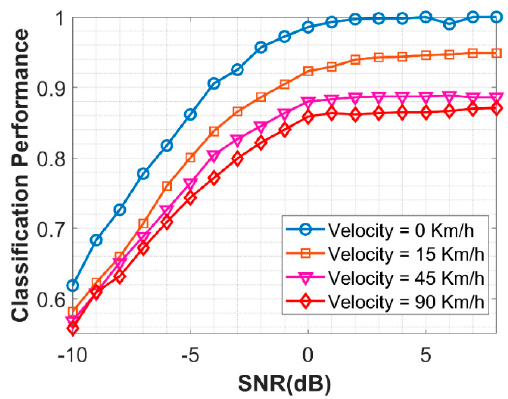
Figure 13. The Performance of NSVM with different Doppler Shifts relative to Velocity.